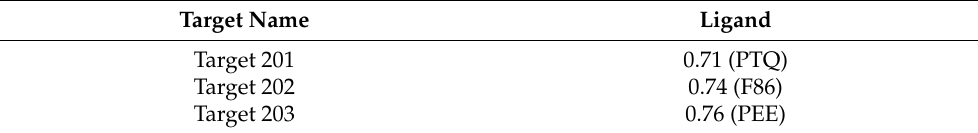
Table 7. Q-score of our best model (EM004_1) for three targets.